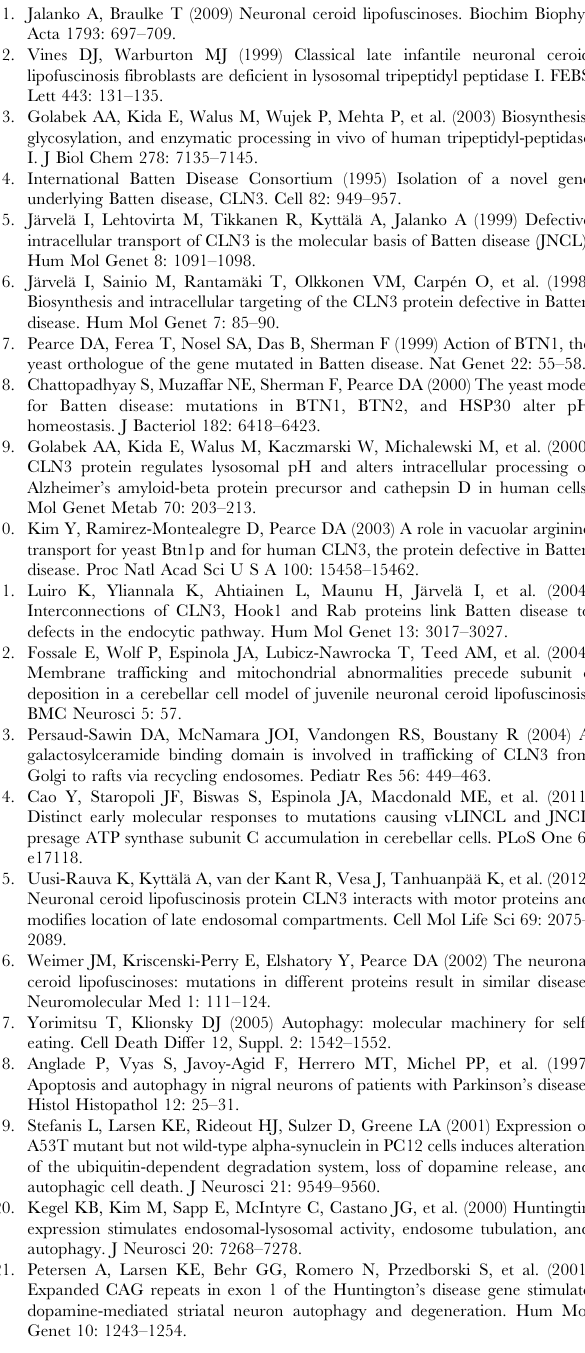
Figure S4 Calibration curves of intralysosomal pH. Calibration curves for FITC-dextran under pHs from 4.5 to 7.0 were obtained in high and low proteolysis media as described in Materials and Methods. Regression equations and the correlation coefficients are